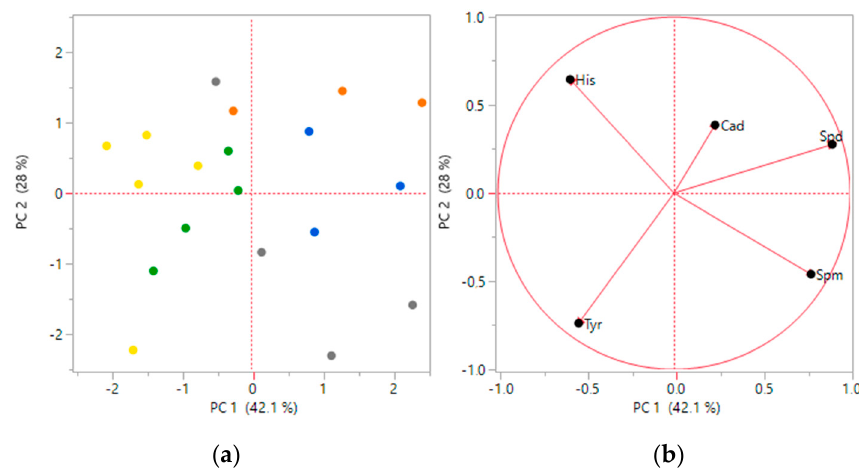
Figure 6. Scores plot ( a ) and loadings plot ( b ) of all samples except barley. Spelt: Blue, Oat: Orange, Millet: Yellow, Quinoa: Green, Rice: Grey.